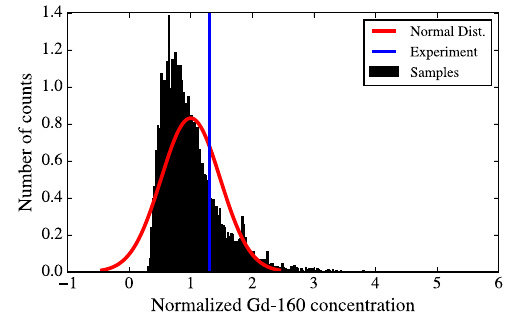
Figure 1. Histogram of the prior calculated Gd-160 concentra- tions normalized to the